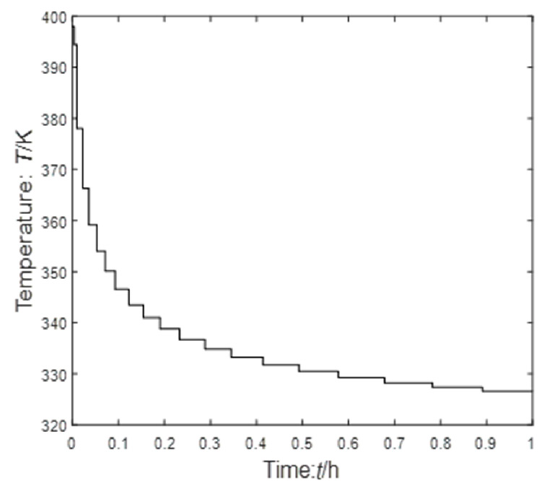
Figure 3. Optimal temperature control trajectory ( N = 20).